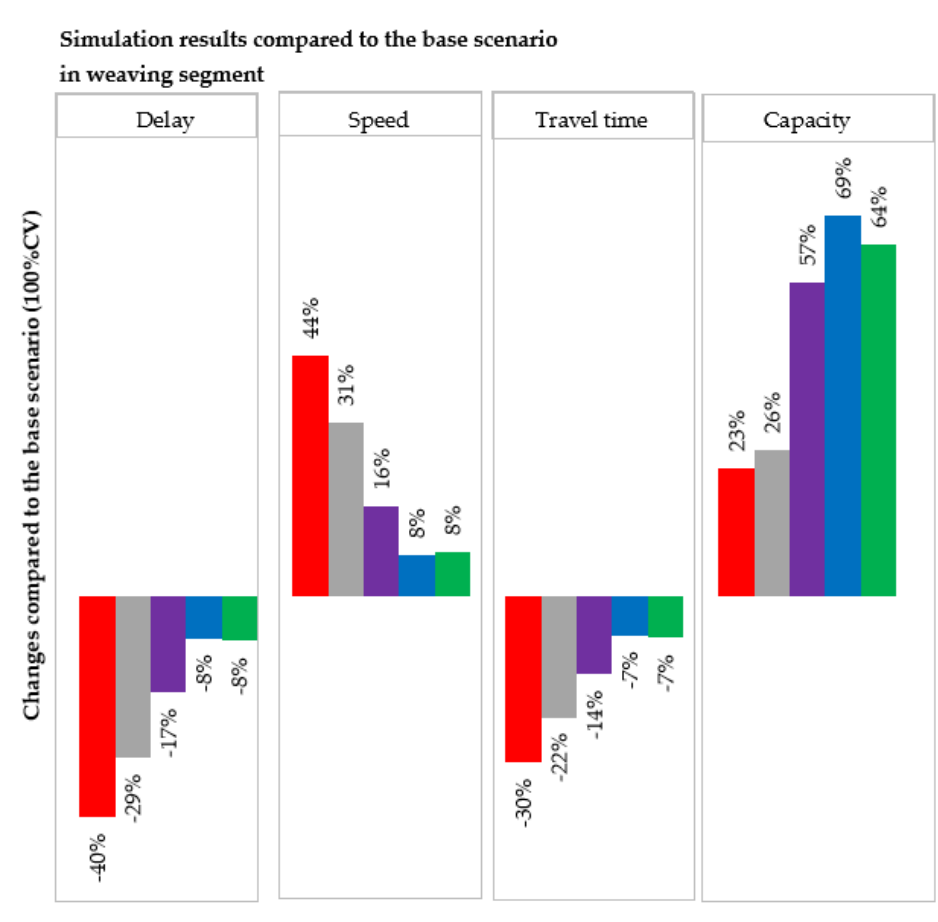
Figure 11. Simulation results of traffic flow parameters compared to the base scenario (100% CV): weaving segment.